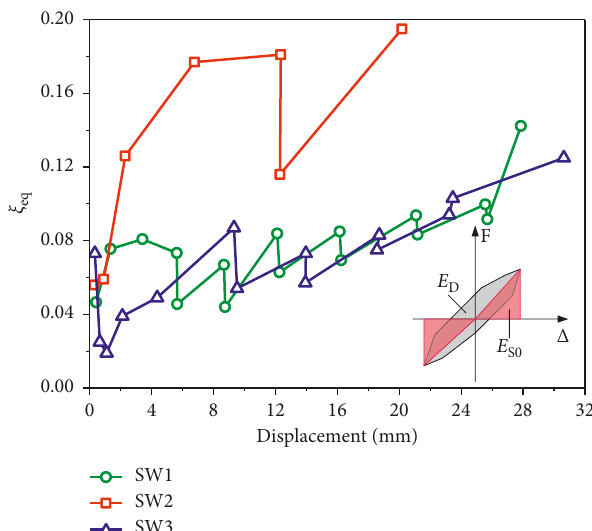
Figure 18: Equivalent viscous damping ratio of the specimens.